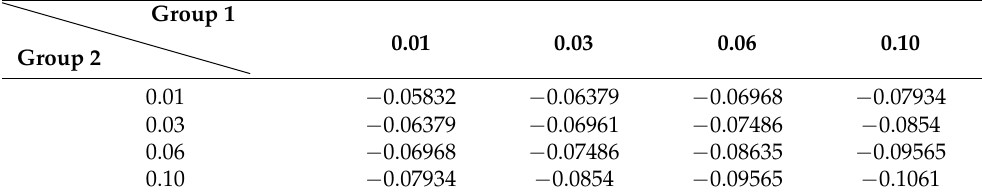
Table A6. Damping coefficient for TM4 of SG under different K p .